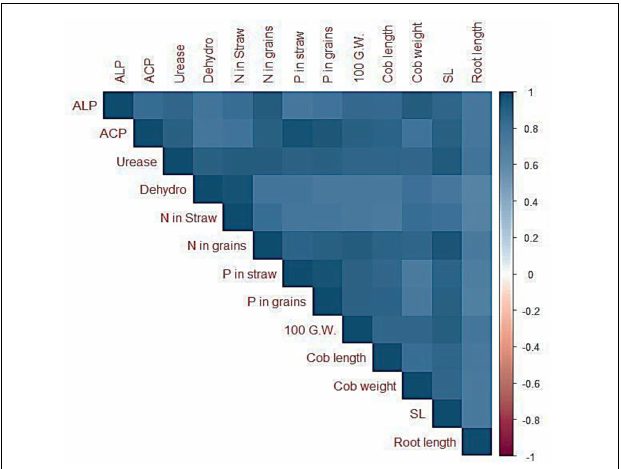
FIGURE 7 | Correlation graphs between soil enzyme activities and growth and yield parameters as well as nutrient acquisition. ACP = Acid phosphatase; ALP = Alkaline phosphatase; DH = Dehydrogenase; CL = cob length; CW = Cob weight; SL = Shoot length; RL = Root length; 100 G.W. = 100 grain